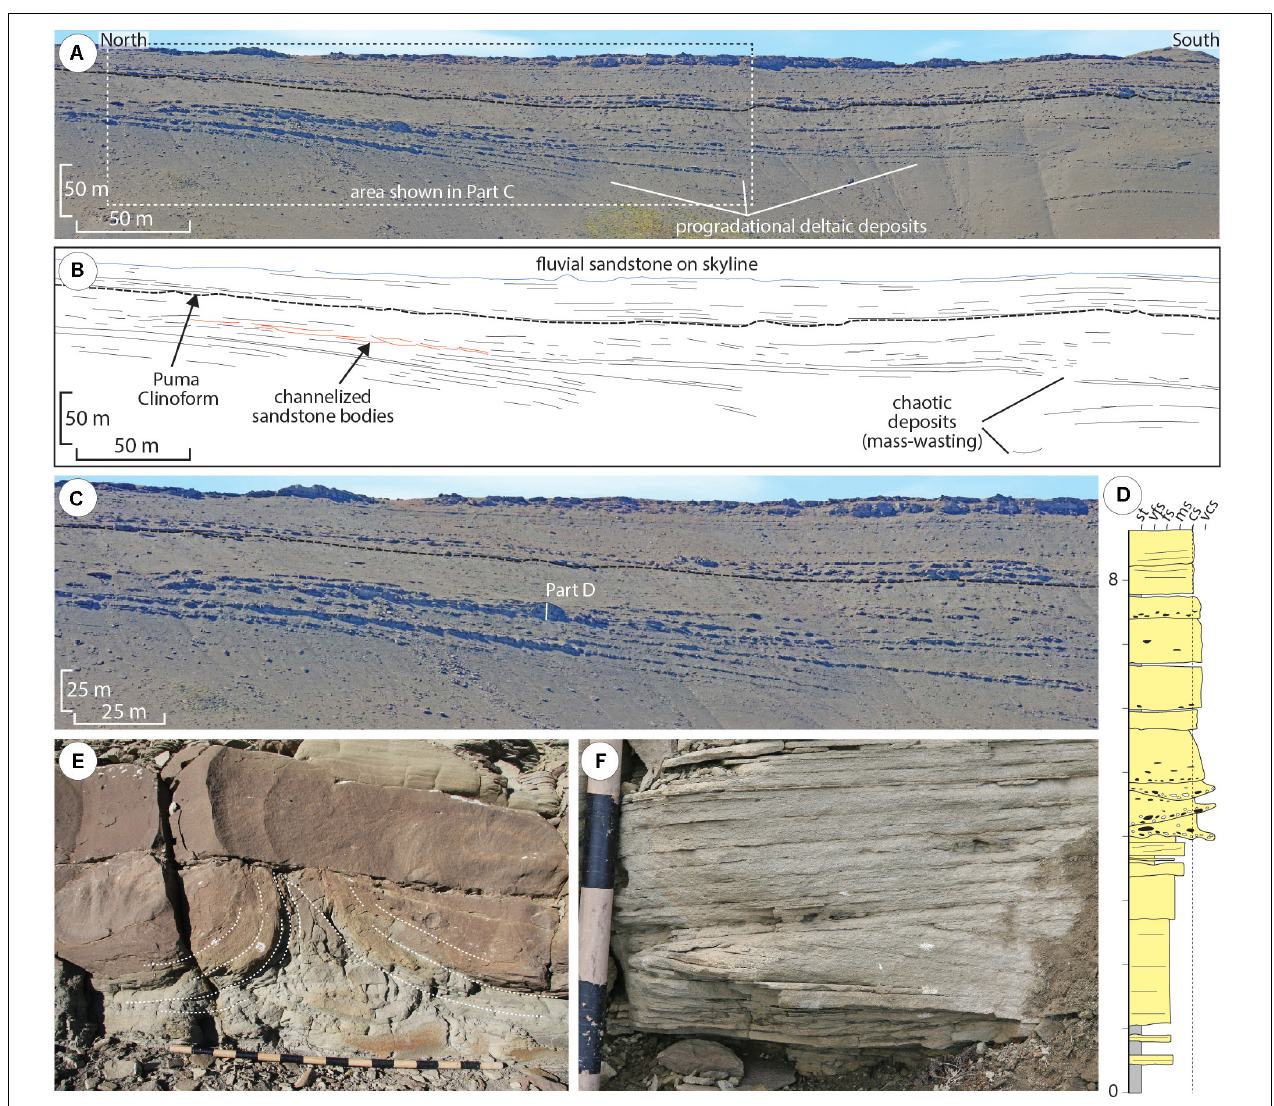
FIGURE 11 | (A) Photo-mosaic and (B) line-drawing trace of the upper portion of the Oveja shelf margin and the proximal deposits overlying the Puma clinoform showing river dominated deltaic clinoforms dipping basinward and transitioning into siltstone-dominated slope deposits. See Figure 10A for location. (C) Photo mosaic of deltaic clinoform topset highlighted in (A) . (D–F) Facies of the upper section of the Oveja clinothem, including: (D) Detailed stratigraphic section of typical sandstone-dominated coarsening upward package with interbedded carbonaceous mudstone (F14) and thin-bedded sandstone (F13) overlain by planar-laminated sandstone (F8) and coarse- to very coarse-grained lenticular sandstone (F7). Section location is shown in (C) . (E) Loading structure in medium-grained sandstone (F10); Jacob staff at base of photo is 1.5 m long (outcrop location is top of Toro section; Figure 3 ). See bed in measured section ( Figure 7C ) at 35 m for